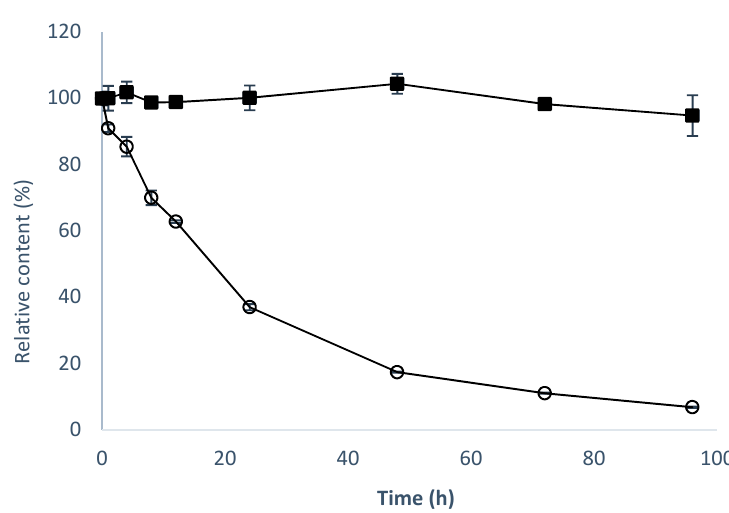
Figure 5. Alkaline stability of 8-OHDe (open circle) and 8-OHDe-7- O - α -glucoside (closed square). A total of 1 mg/mL of the tested compound was dissolved in 50 mM of Tris buffer at pH 8.0, and stored at 20 °C for 96 h. During the storage time, samples were taken out for UPLC at the determined interval times. The mean ( n = 3) is shown, and the standard deviations are represented by error bars.